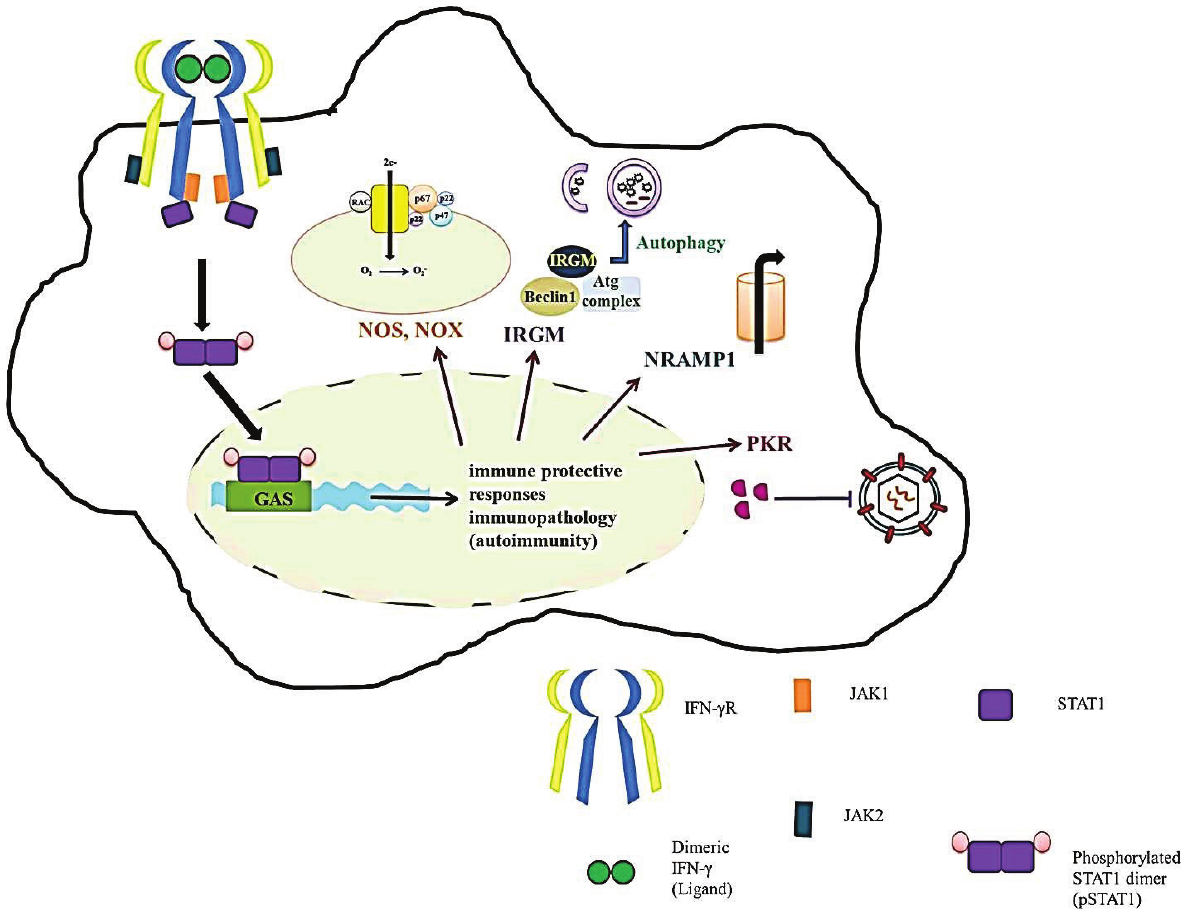
Figure 2: Protective effects of IFN-γ. IFN-γ primes the macrophage to improve its anti-microbial capacity. The biological protective effects commence upon binding of a dimeric IFN-γ to its cognate receptor on the macrophage surface. This binding leads to a series of phosphorylation reactions that ultimately phosphorylate STAT1 proteins. Following phosphorylation of STAT1 molecules, these homodimeric molecules translocate to the nucleus where they bind to GAS elements on the DNA. This triggers a plethora of downstream effector genes that encode products necessary for pathogen containment. IFN-γ -regulated proteins include Reactive Oxygen Species, Reactive Nitrogen Intermediates, autophagy proteins, efflux pumps or antiviral mediators. Besides, controlling infection, IFN-γ can serve as a double-edged sword in an immune dysfunctional state, such as autoimmunity, wherein it can exacerbate disease symptoms due to prolonged pro- inflammatory